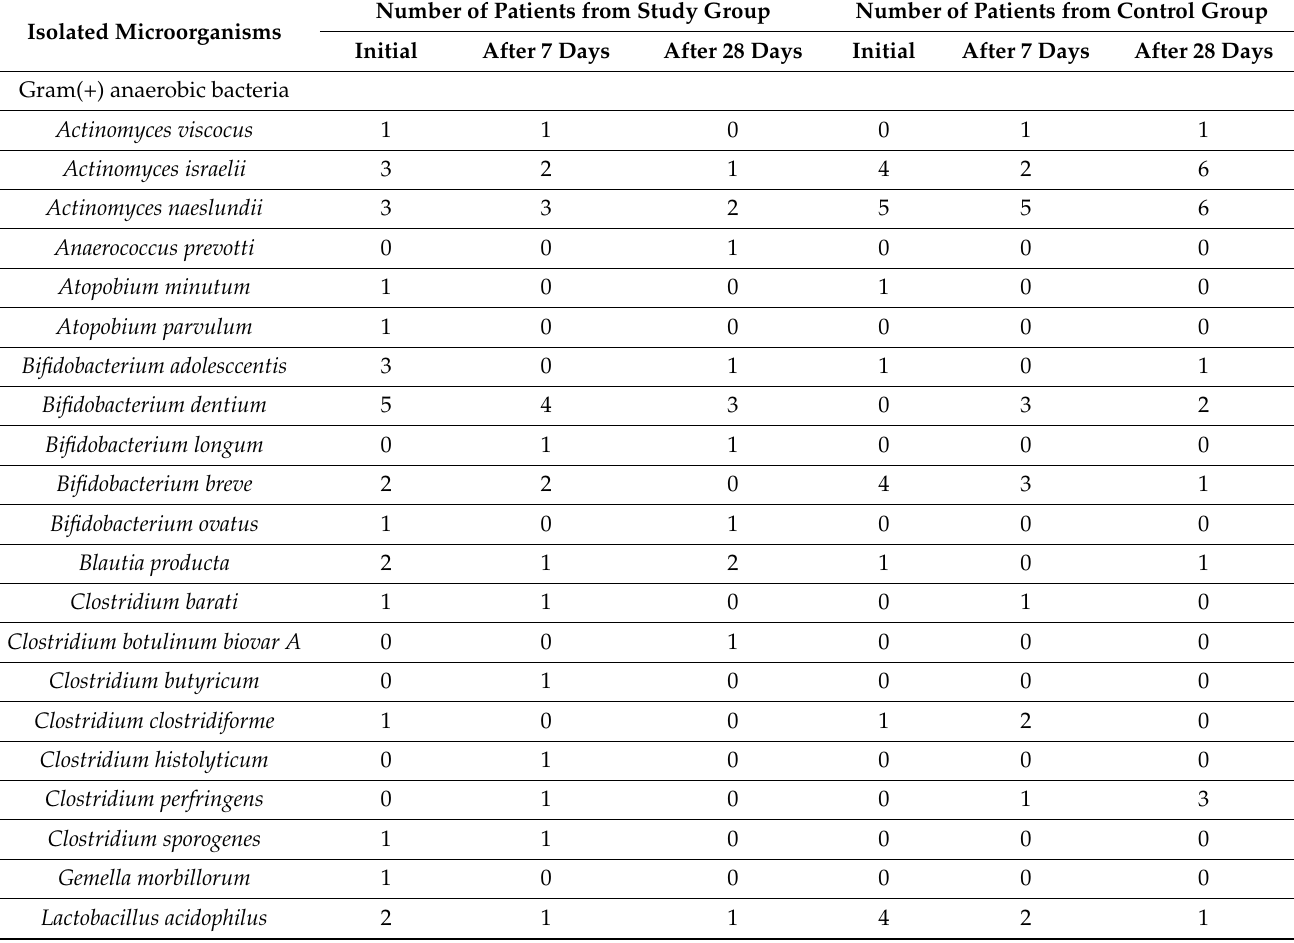
Table 5. Microorganism species isolated from patients using the toothpaste with EEP and TTO (study group) or without EEP and TTO (control group). Number of Patients from Study Isolated Microorganisms